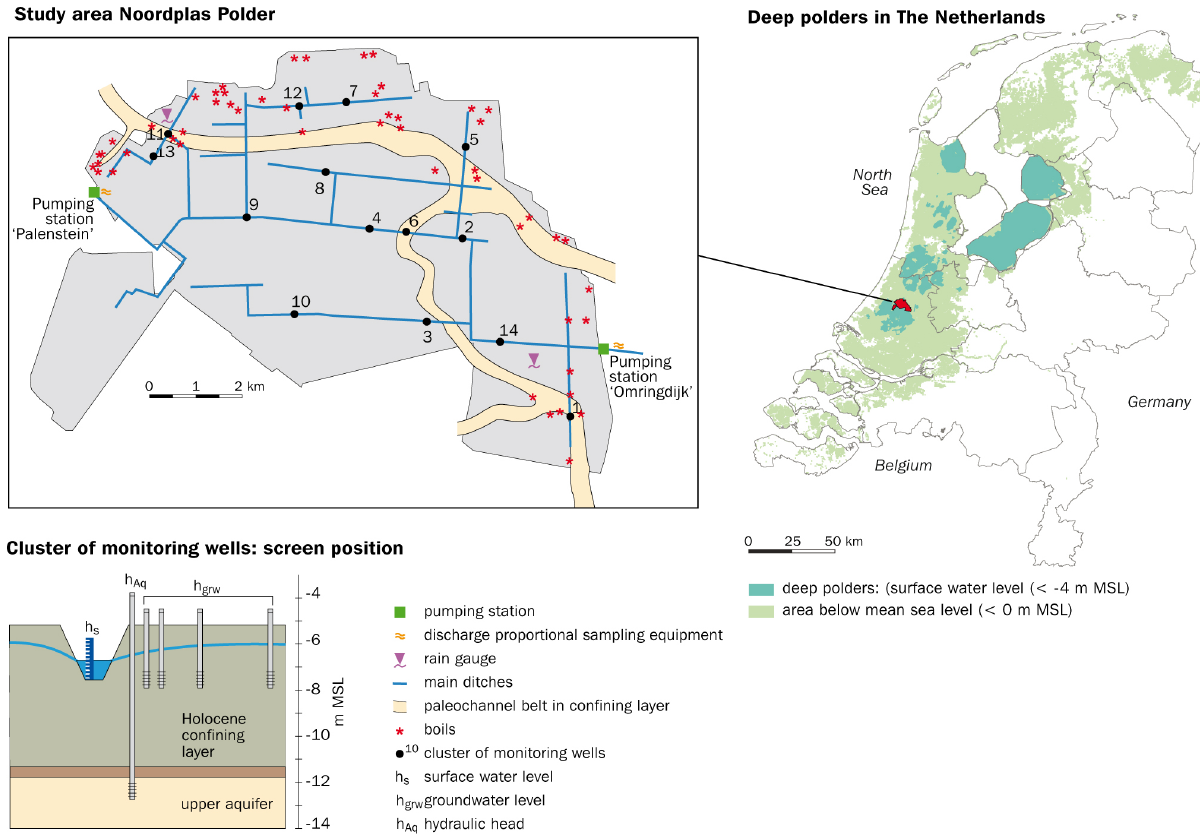
Fig. 2. Set up of the monitoring network of the Noordplas Polder and the location of the sandy paleochannel belts and boils (adapted from De Louw et al.,